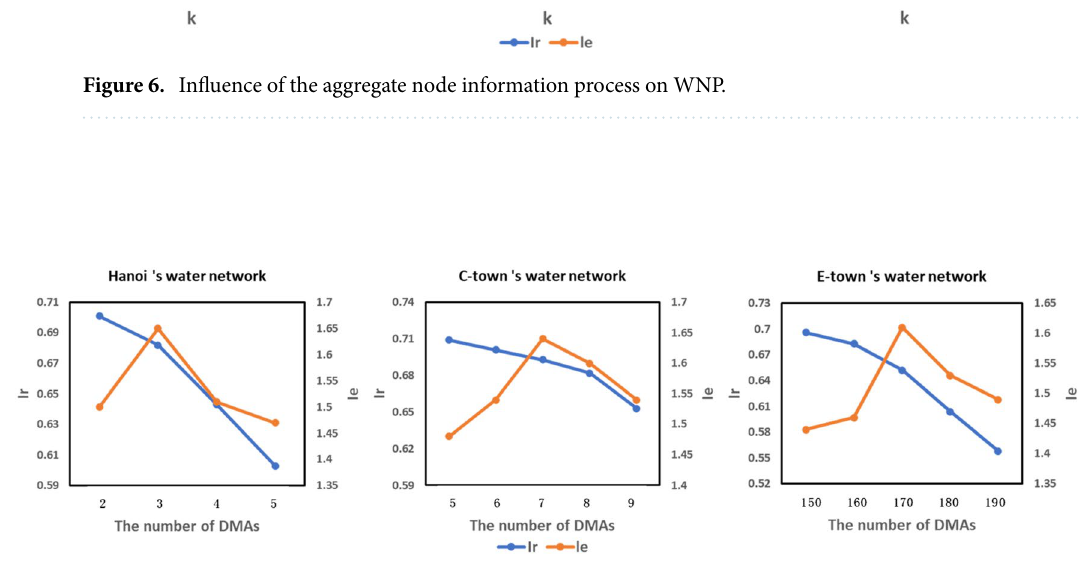
Figure 7. Influence of the number of DMAs on